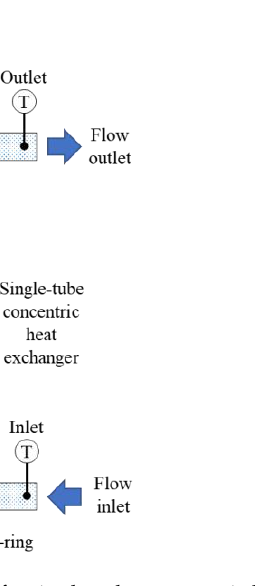
Figure 6. Detailed illustration of a single-tube concentric heat exchanger in a water-heating loop. The air-cooling duct consisted of an air-duct body and frame, a cooling fan, and a flow straightener. In the air duct, the air flowed vertically from the bottom toward the top.